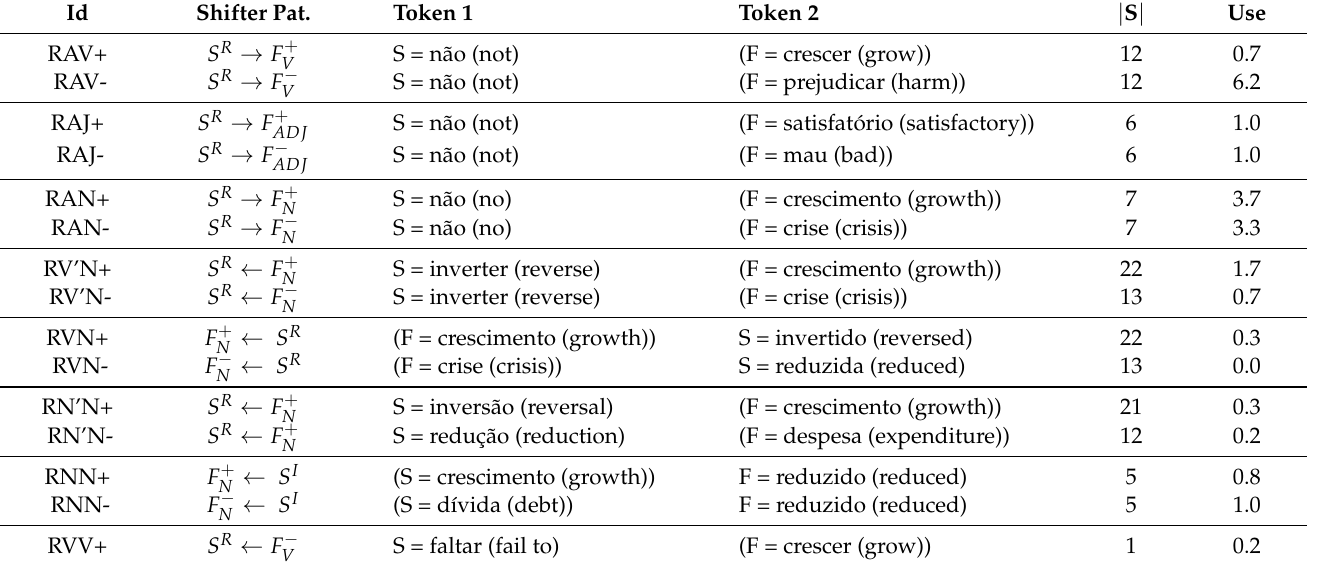
Table 7. Some shifter patterns that include